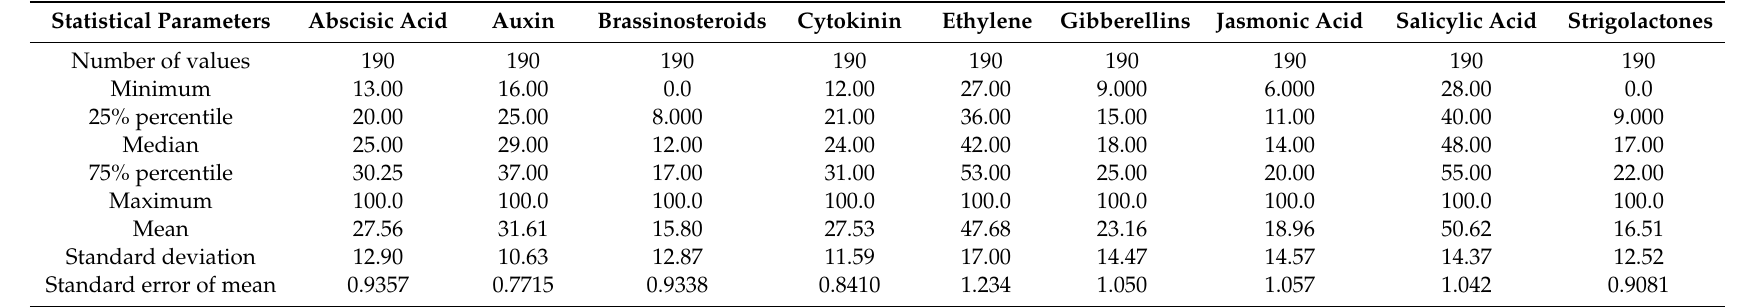
Table 2. Statistical details of phytohormone search over di ff erent